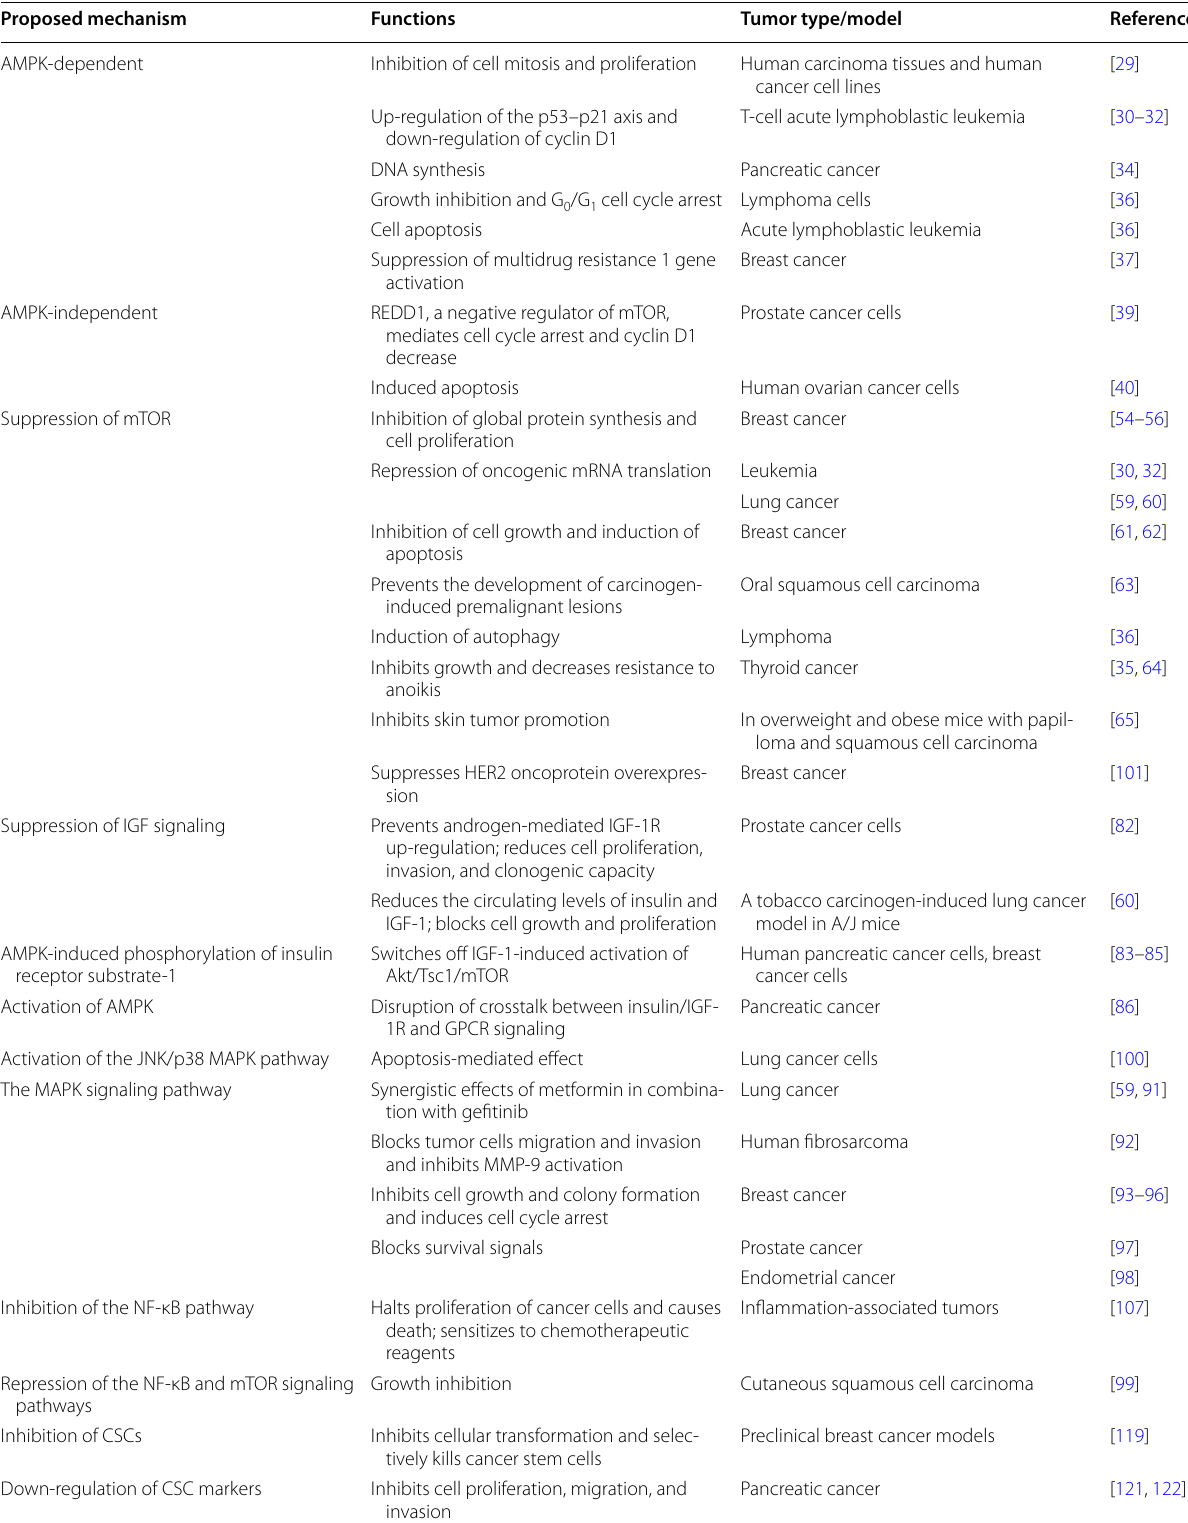
Table 1 Metformin targets multiple signaling pathways in cancer Proposed